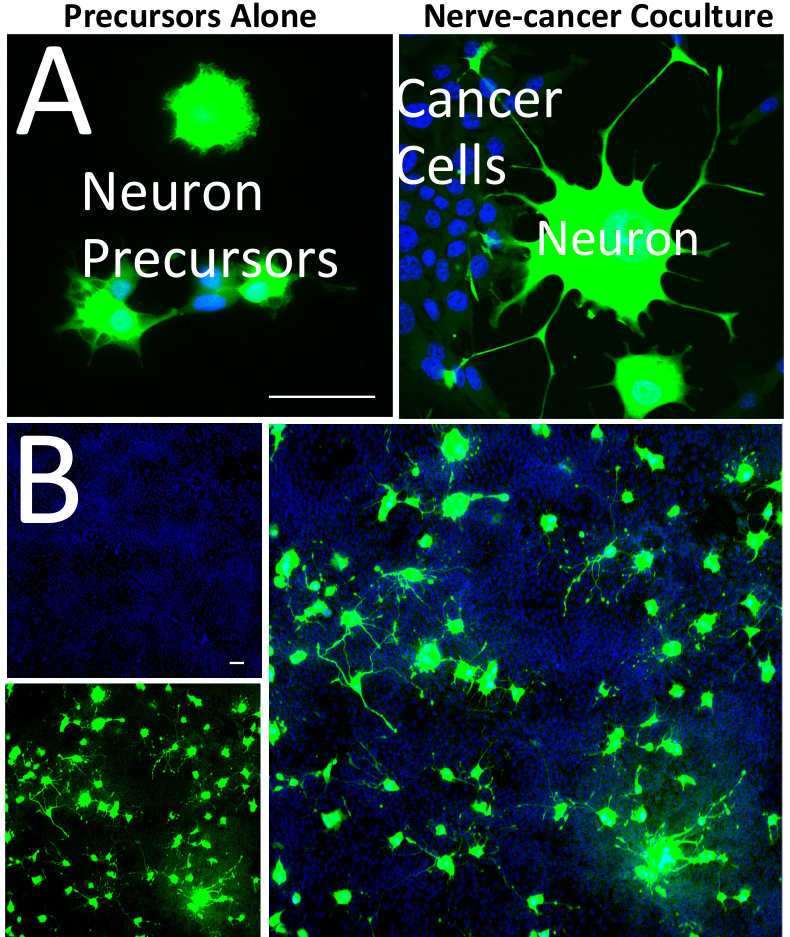
Figure 1. Cancer-induced neuronal precursor differentiation. ( A ) Fluorescence microscopy analysis of PC12 neuronal precursors in direct coculture (nerve-cancer coculture) with breast immortalized cells (NMuMG—Normal Murine Mammary Gland) demonstrates the development of axons and dendrite protrusions that come into contact with the cancer cells ( right ). PC12 cells are distinguished from NMuMG cells by stable, constitutive expression of the GFP fluorophore (green channel), while all cell nuclei of the culture are stained with DAPI (blue channel). PC12 cells cultivated alone (precursors alone) show only a low development of neurites ( left ). ( B ) At low magnification, an extended network of neurites is visible after five days of coculture, suggesting the formation of a new nerve-cancer interface. While the constitutive GFP approach allows for the observation of PC12 precursor differentiation in coculture models by morphology-based measurement of their degree of differentiation, it does not permit rapid, high-throughput quantification of neuronal differentiation and makes it difficult to assess the intermediate states of differentiation. Scale bars: 50 µ